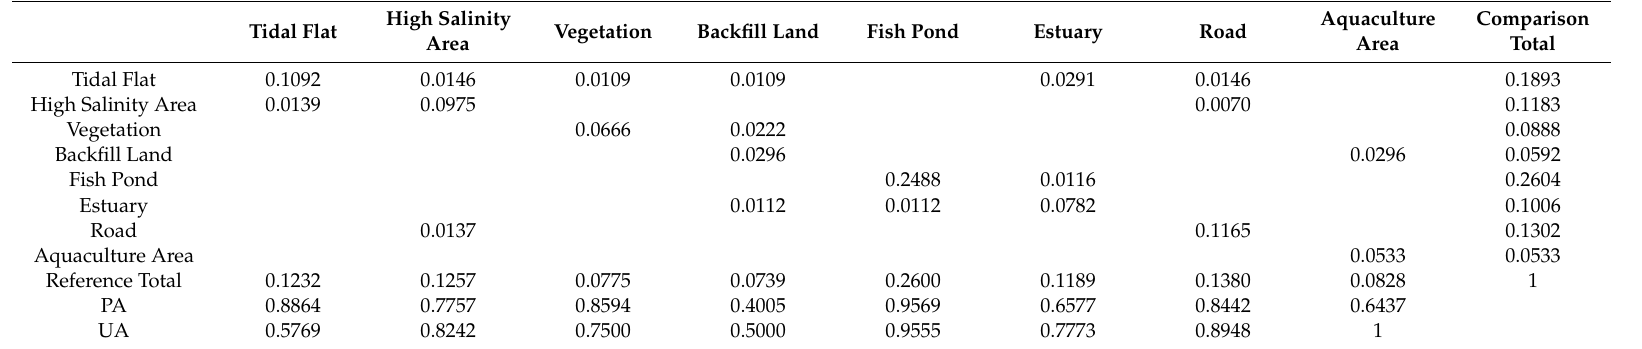
Table 11. Estimated population matrix of the SVM method in the Landsat-8